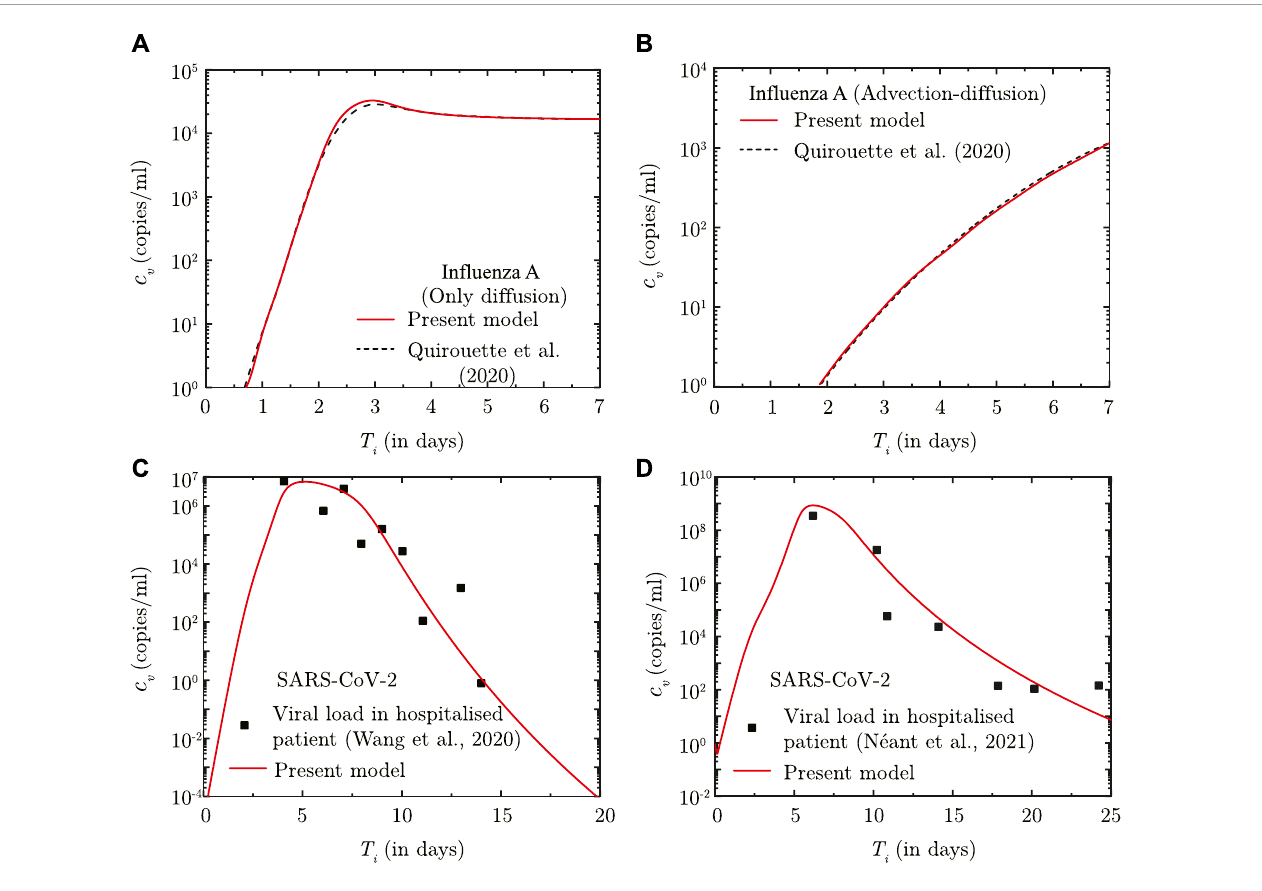
FIGURE 1 (A, B) Comparison between the results obtained using the present model and Quirouette et al. (2020) for Influenza A infection with respect to temporal change in spatially-averaged viral load in presence of (A) virus diffusion only and (B) considering combined virus diffusion and mucociliary advection. (C, D) Comparison of temporal change in the dimensional viral load ( c v ) predicted using the present infection kinetics-immune response model for patients hospitalised with SARS-CoV-2 infection with clinically determined viral load from (A) lower respiratory tract (Wang et al., 2020) and (B) nasopharyngeal region (Néant et al., 2021). T i denotes time (in days) post onset of infection.